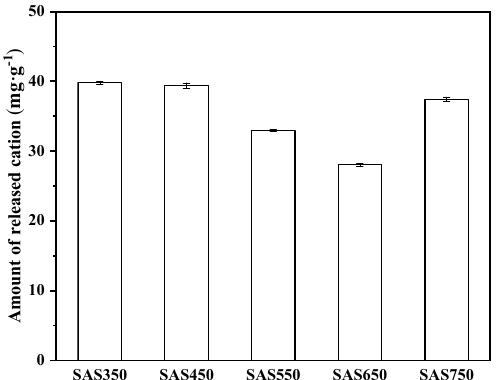
Figure 5. The amount of total cation released from spent Agaricus bisporus substrate biochars (SABCs) into solution (initial pH of 5, 24 h, adsorbent dosage of 1 g·L − 1 ). Compared with the blank experiment, the released amounts of Ca 2+ and K + in the solution after SASC sorption (containing heavy metals) increased, while the released amount of Mg 2+ changed substantially only in SAS750. (Figure 6) In most cases [47], the cation exchange during the sorption of low-temperature biochar (~550 °C) was stronger than that at high-temperature ( ≈ 750 °C). In this study, it was found that the increment of cation release from the solution after the pyrolyzed biochar adsorbed heavy metals at 550 °C was apparently lower than those at other pyrolysis temperatures. For example, for the sorption of Cu(II), the samples are ordered according to the total amount of cations that were released as follows: SAS550 (3.23 mg·g − 1 ) < SAS650 < (9.49 mg·g − 1 ) < SAS450 (9.61 mg·g − 1 ) SAS750 < (11.59 mg·g − 1 ) < SAS350 (18.09 mg·g − 1 ). The reasons for this could be mainly attributed to the structure of crystalline minerals at 550 °C [21]. These results demonstrate that the pyrolysis temperature affects the process of cation exchange in the sorption of heavy metals by spent mushroom substrate biochar.